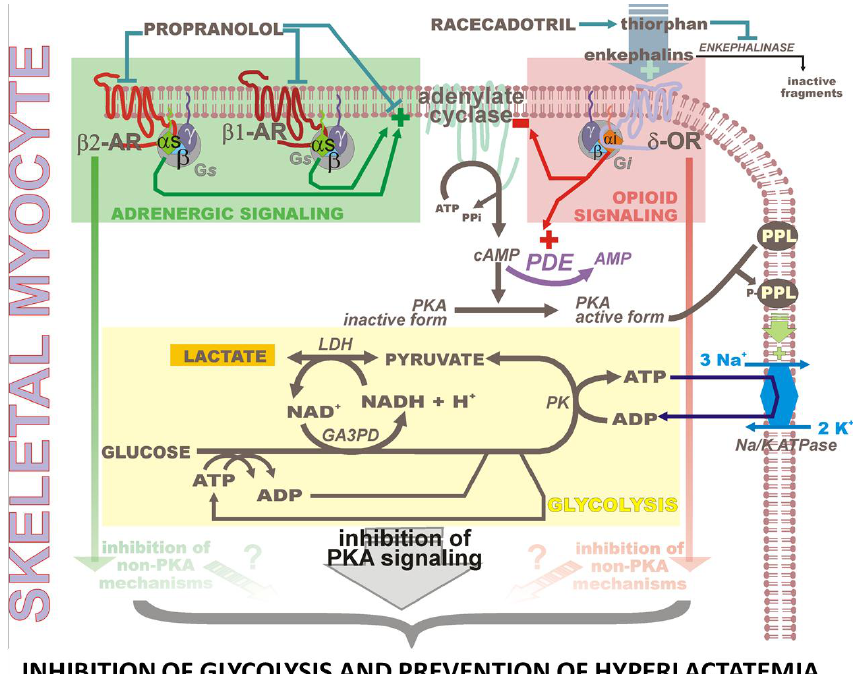
Figure 2. Cross-talk between β-adrenergic and δ-opioid signaling pathways in skeletal myocytes as a theoretical basis for reinforced inhibition of glycolysis and prevention of